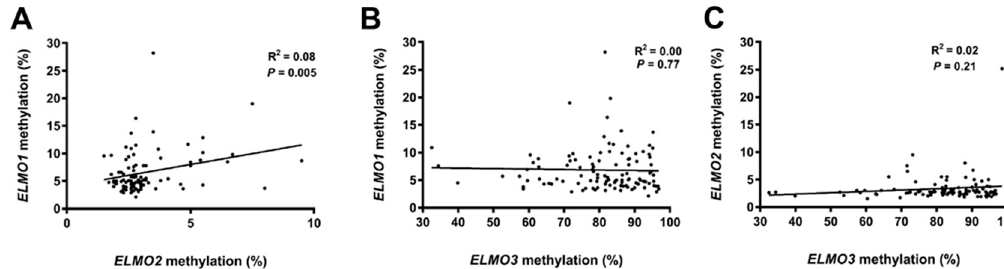
Figure 5. Correlations between the methylation levels of the individual ELMO gene promoter CpG islands. ( A ) ELMO1 vs. ELMO2 ; ( B ) ELMO1 vs. ELMO3 ; ( C ) ELMO2 vs. ELMO3 .